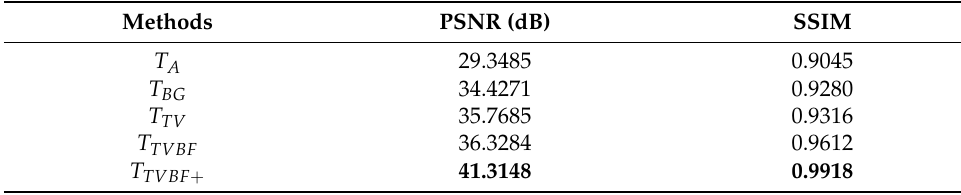
Table 4. The evaluation indices of the synthetic MWRI scenario.